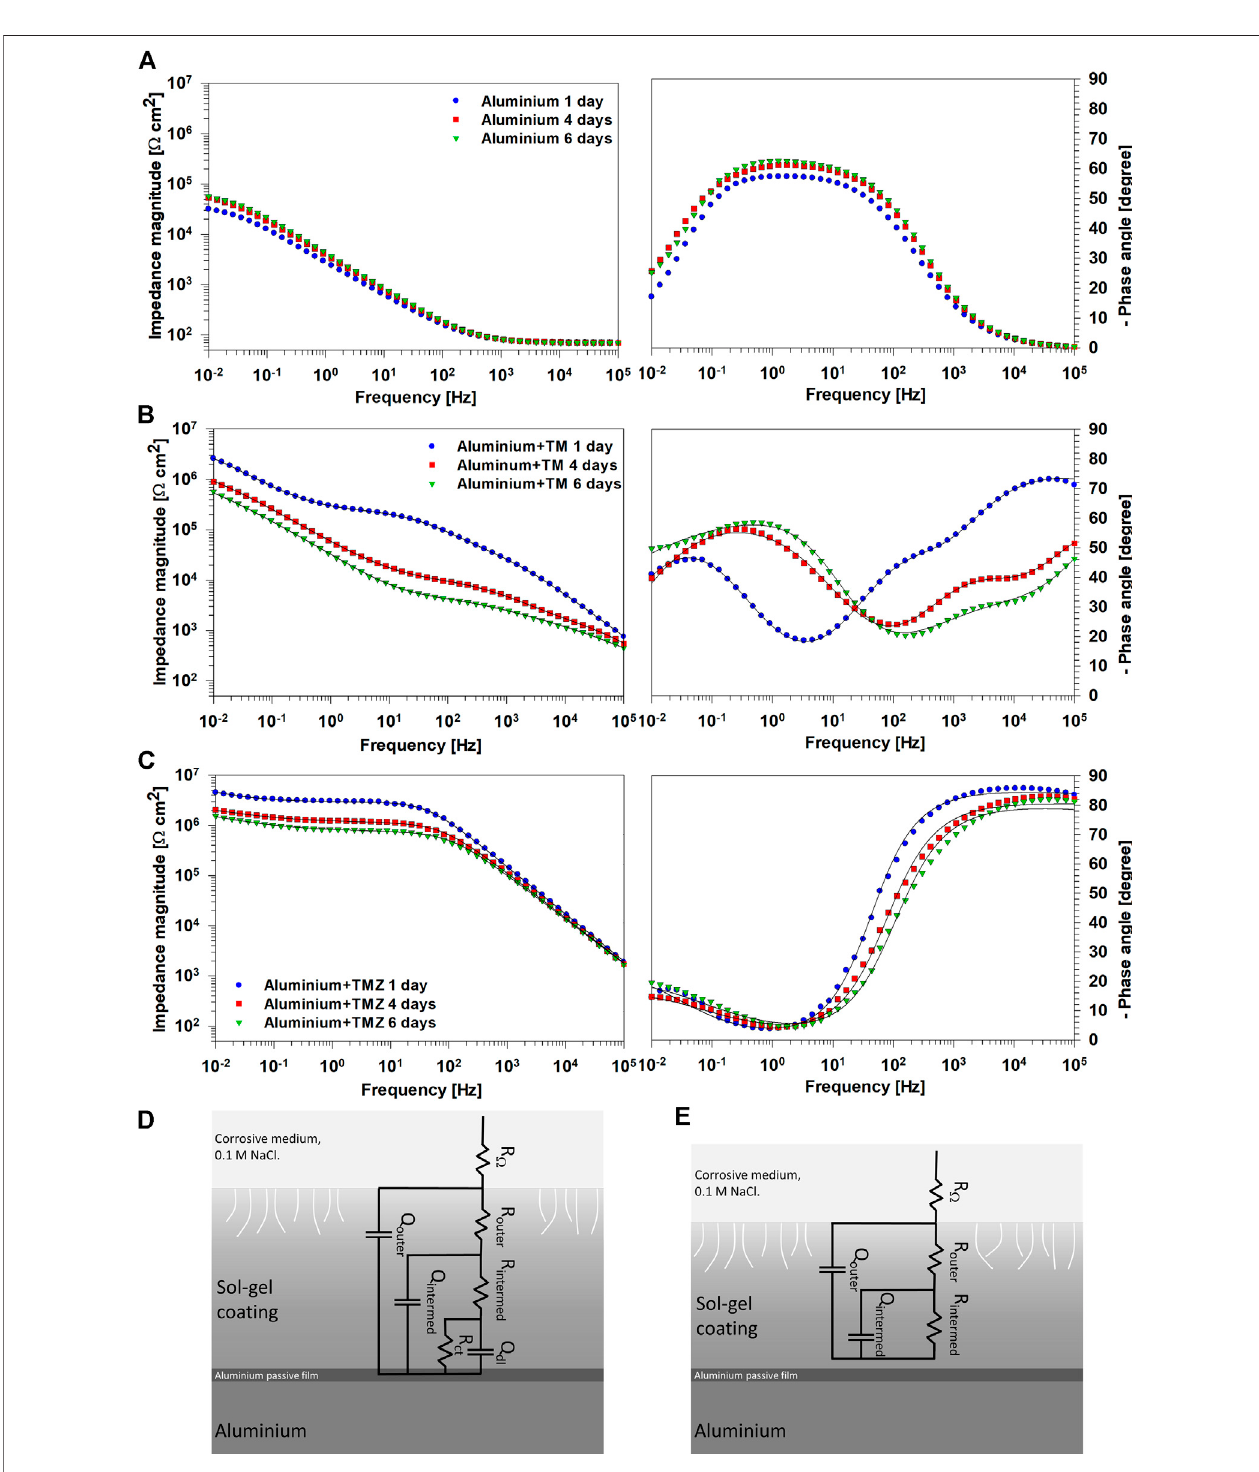
FIGURE 6 | EIS spectra presented as Bode plots of (left) impedance magnitude and (right) phase angle for (A) uncoated ground aluminium and coated with (B) TMand (C) TMZcoatingsrecordedatselectedimmersiontimes(1,4,and6 days)in0.1 MNaClsolution. (B,C) Symbolsrepresentexperimental dataandlinesthe fi tted curves. The electrical equivalent circuits (EECs) used to fi t EIS data are presented: (D) TM coating and (E) TMZ coating.